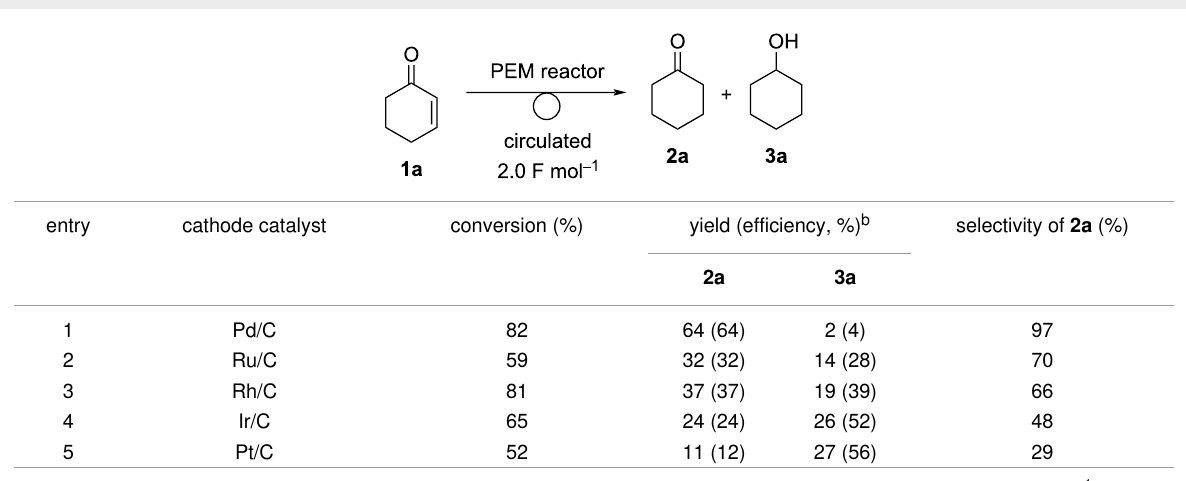
Table 3: Effect of catalysts on the electrochemical hydrogenation of 1a with a circulating PEM reactor. a